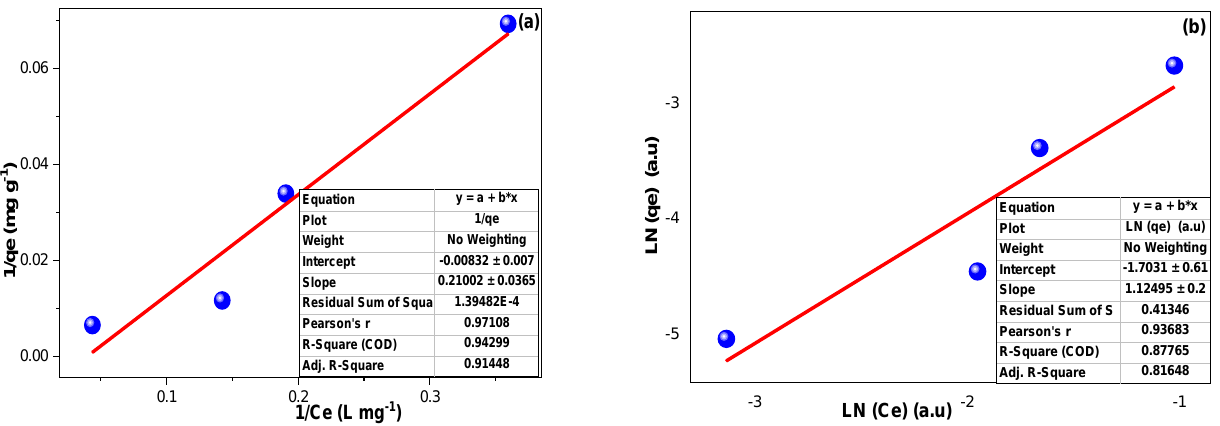
Figure 7. ( a ) Langmuir isotherm and ( b ) the Freundlich isotherm for IC adsorption on BiOI at 25 °C using 10, 20, 50, and 100 mg L − 1 IC solutions.